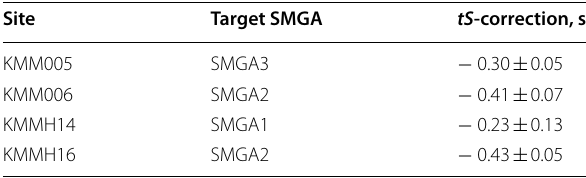
Table 1 Estimated S -wave travel time corrections for each